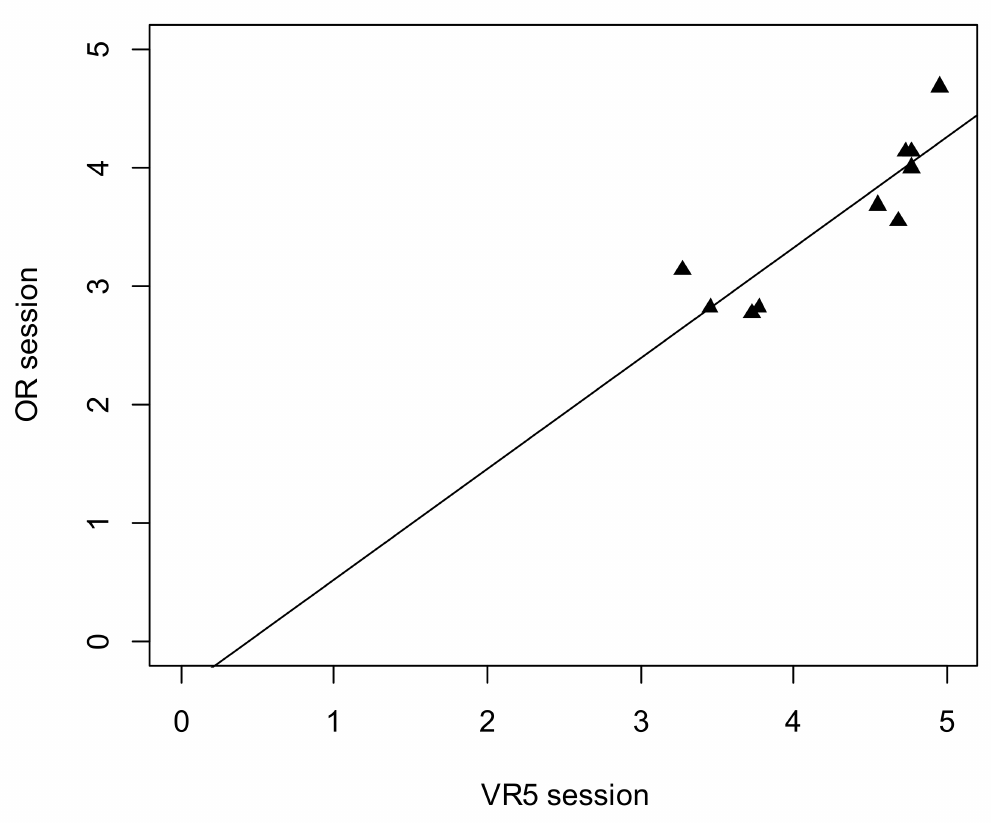
Figure 5. Scatterplot for TBC result between VR5 session and operating room (OR)